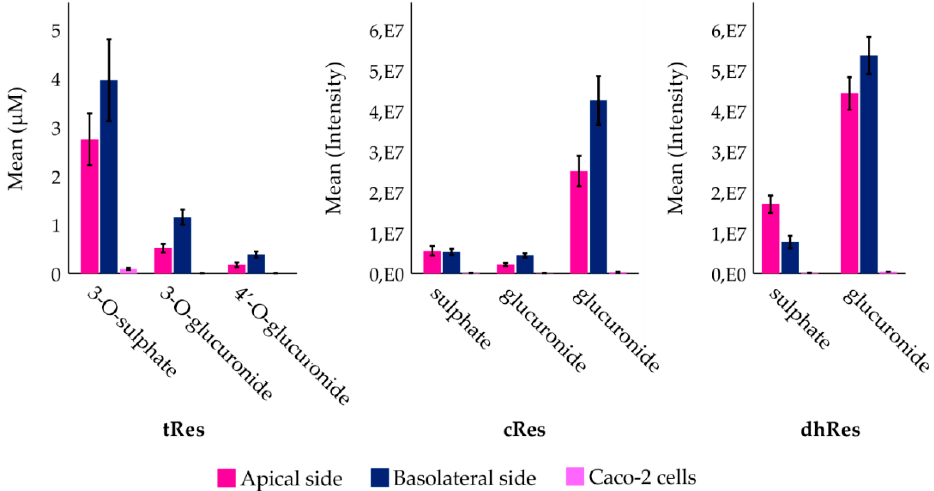
Figure 4. Metabolites observed after 4 h of incubation in Transwell TM cellular system. Values obtained from LC/MS for tRes are expressed as mean concentration ± standard deviation, n = 4; for cRes and dhRes values are expressed as mean intensity ± standard deviation, n = 4 and n = 5, respectively. Steric positions of bonded conjugated units on cRes and dhRes cannot be specified, due to lack of confirmed standards.